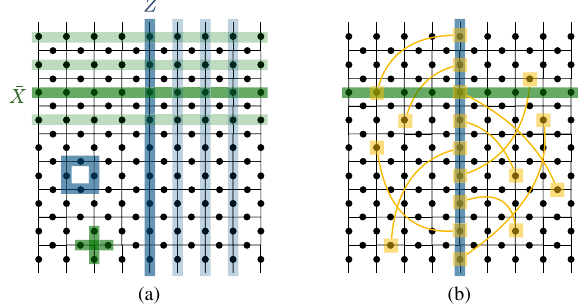
FIG. 1. (a) The 2D surface code has X -vertex and Z -plaquette stabilizer generators and many nonoverlapping representatives of ¯ X ¯ Z logical Pauli (green) and (blue) operators. (b) For a given ¯ Z representative of (blue) and any constant-depth circuit U with possibly geometrically nonlocal gates (depicted in yellow), one ¯ X ¯ ZU † can always find a representative of (green), such that U ¯ X and overlap only on a constant number of